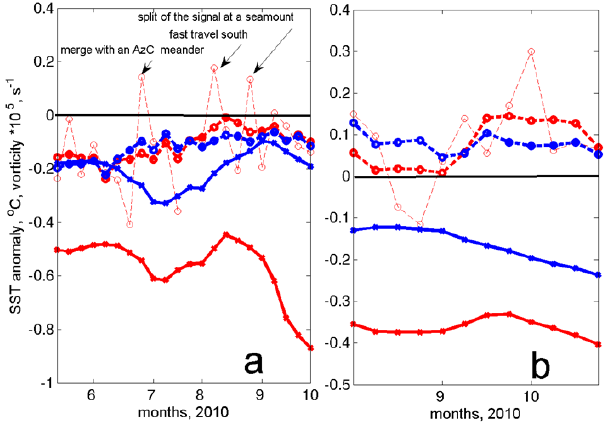
Fig. 5. Monthly running means of SST anomaly ( ◦ C, thick dashed lines) and relative vorticity (10 − 5 s − 1 , solid lines) of the surface signal of Meddy 1 (a) and of the AzC meander (b) . The red lines are SST 25 –SST 100 and mean relative vorticity in the 25-km cir- cle around the vortex centre; the blue lines are SST 50 –SST 100 and mean relative vorticity in the 25–50-km ring around the vortex cen- tre. The SST 25 –SST 100 with original (weekly) temporal resolution is also shown as thin red dash